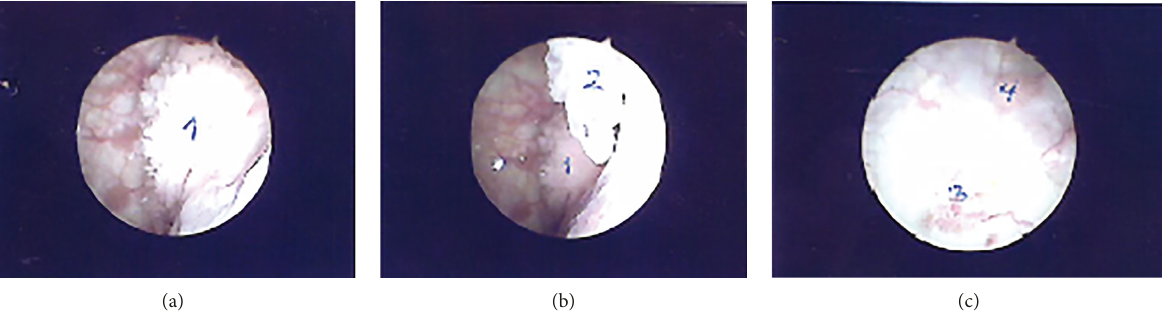
Figure 4: Four tumors seen at initial cystoscopy.